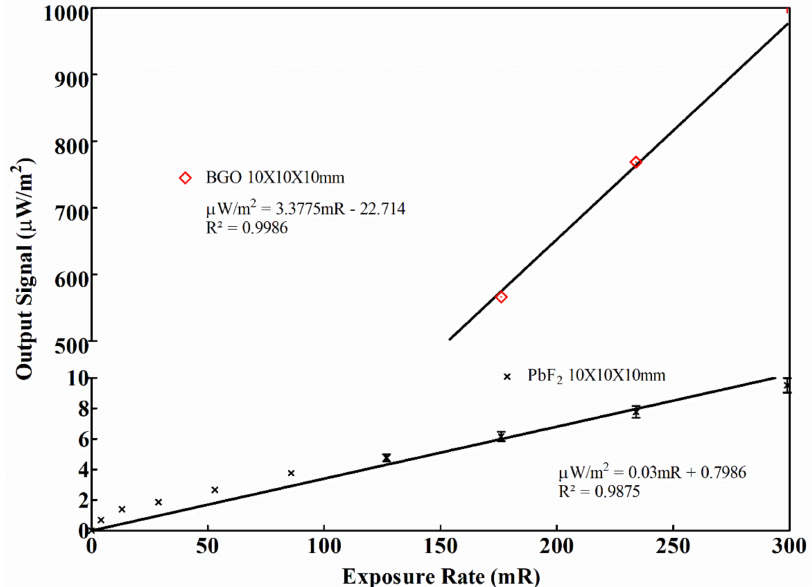
Figure 5. Output signal of PbF 2 and BGO crystals in the X-ray exposure rate range 0–299 mR/s. XLE values of PbF 2 are shown in Figure 6, against the corresponding values for BGO.